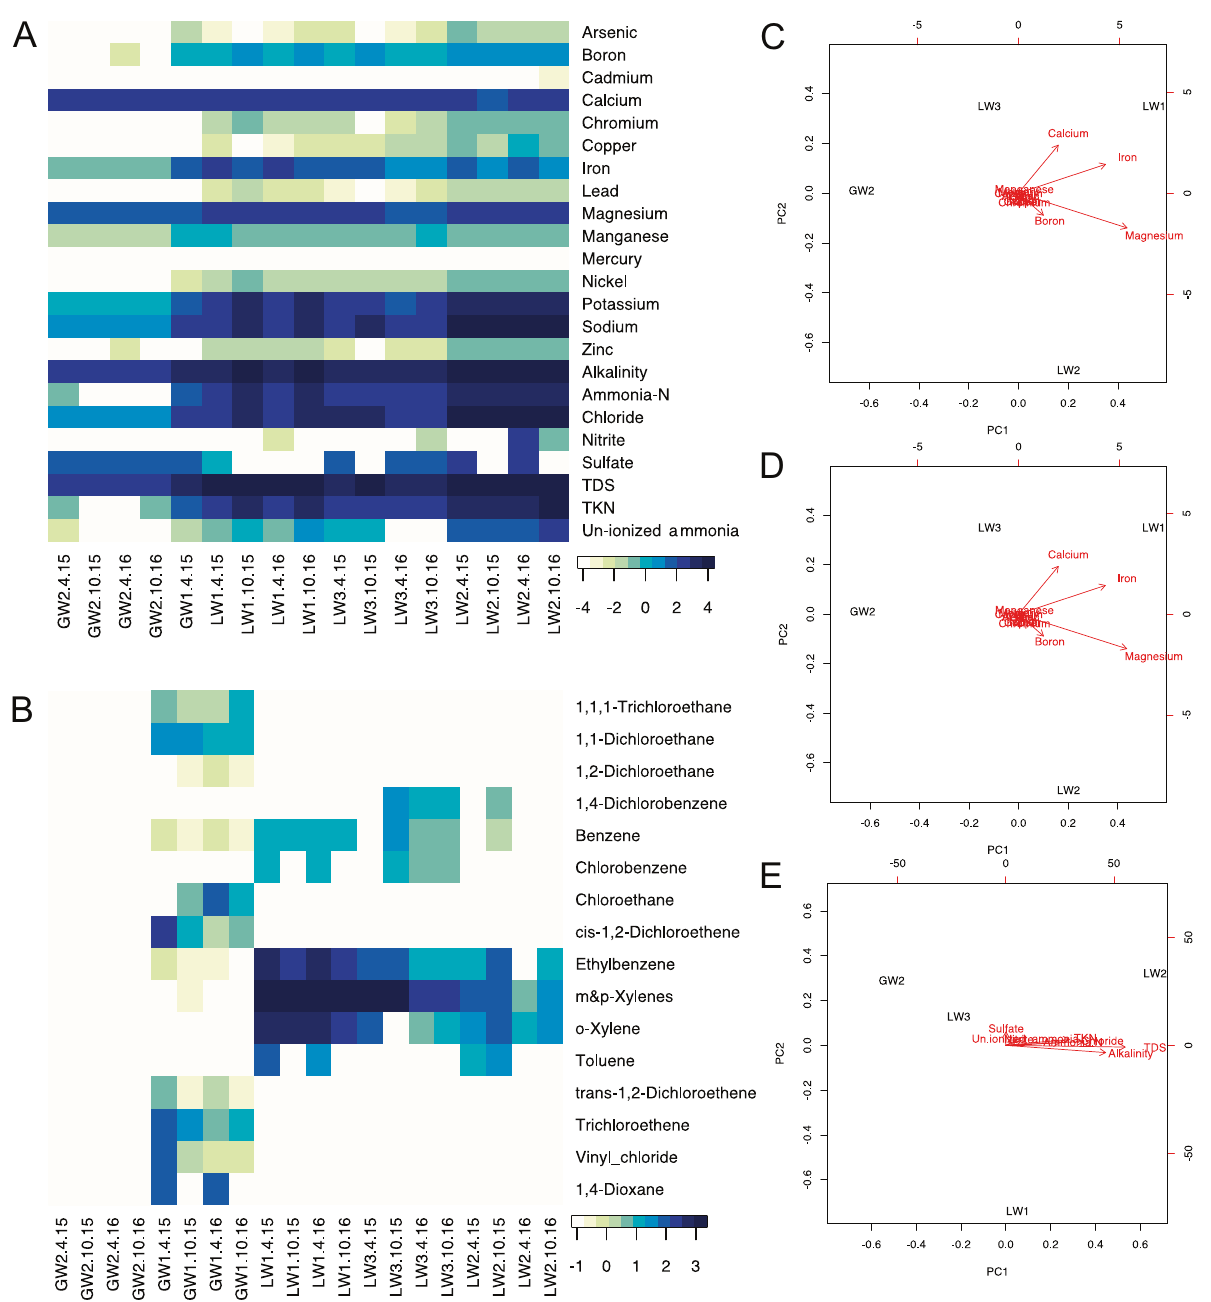
Fig. 5 Environmental variation between land fi ll and aquifer sites for non-volatile (mg/L) and volatile (µg/L) compounds. A Heat map of non-volatile compound concentrations and other site parameters (log10 transformed) across four dates for the three leachate wells and the unimpacted groundwater well. Only one date (April 2011) was available for the impacted groundwater well (GW1). Stars indicate low levels of cadmium and mercury not visible on the heatmap that may be biologically relevant. B Heat map of volatile compound concentrations (log10 transformed) across four dates for the leachate and groundwater wells. C Principal component analysis of metal concentrations at the three leachate wells and the unimpacted groundwater well. Metal concentration data was square root transformed. PC1 explains 79.6% of variation and PC2 explains 18.4% of variation. D Principal component analysis of volatile compound concentrations at the three leachate wells and the unimpacted groundwater well. Volatile compound concentration data were square root transformed. PC1 explains 97.4% of variation and PC2 explains 2.4% of variation. E Principal component analysis for non-metal, non-volatile compounds, derived from measurements at the three leachate wells and the unimpacted groundwater well. Concentration data was square root transformed. PC1 explains 99% of the